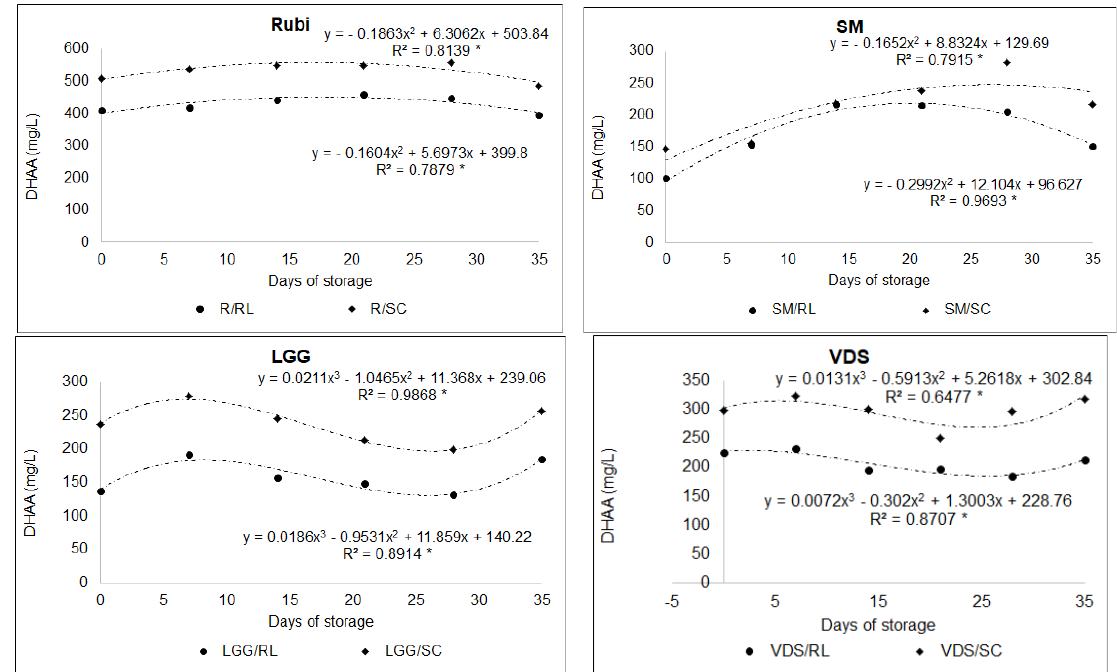
Figure 2. Ascorbic acid concentration (mg/L) in juices of Sanguínea de Mombuca (SM), Rubi (R), Lue Gin Gong (LGG), and Valencia Delta Seedless (VDS) sweet orange cultivars with different rootstock combinations subjected to 0, 7, 14, 21, 28, and 35 days of storage. RL —‘Ranpur’ lime; SC —‘Swingle’ citrumelo.